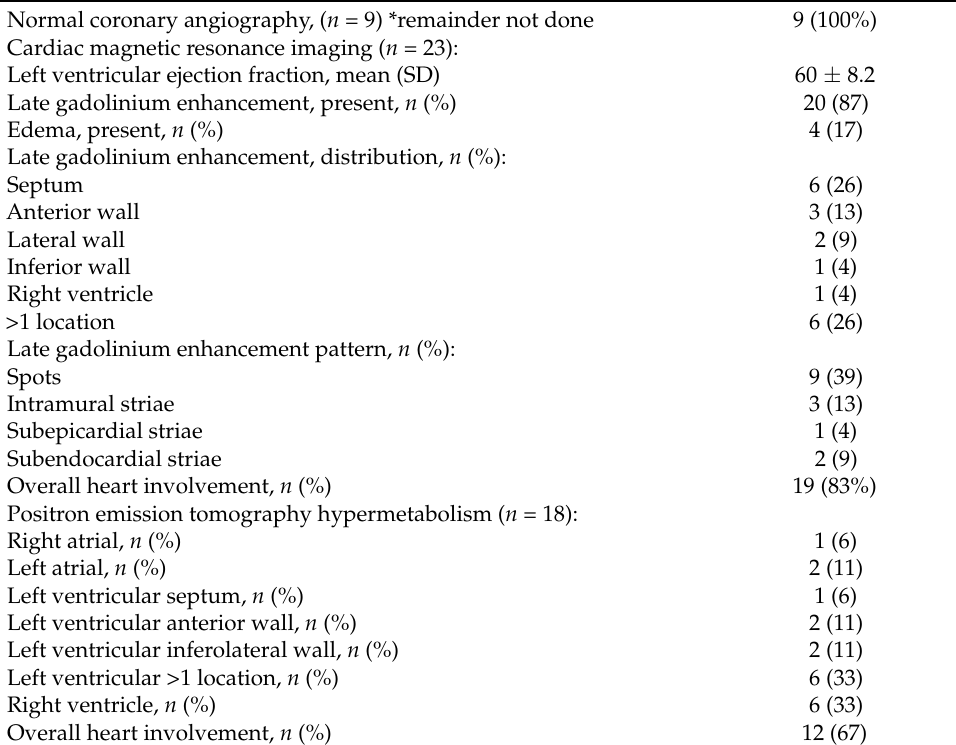
Table 3. Cardiac imaging features of cardiac sarcoidosis patients ( n = 29). Normal coronary angiography, ( n = 9) *remainder not done 9 (100%)